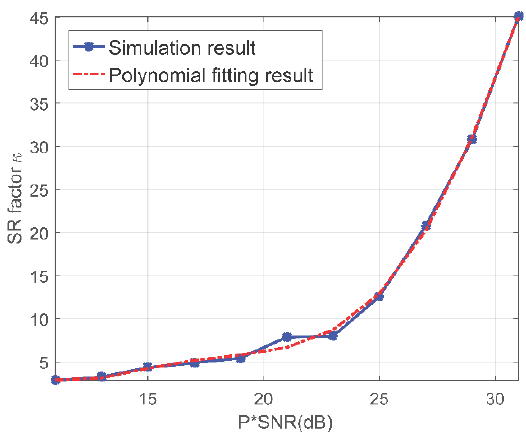
Figure 5. Super-resolution factor versus different 𝑃 ∗ 𝑆𝑁𝑅s .